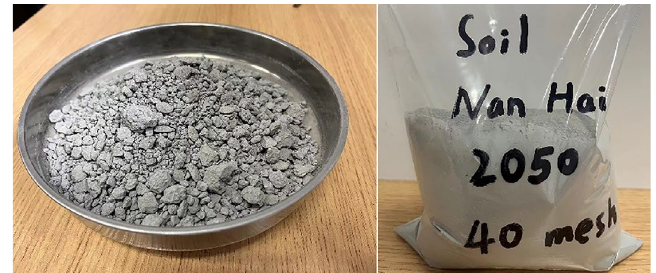
Figure 4. Formation cuttings and soil.